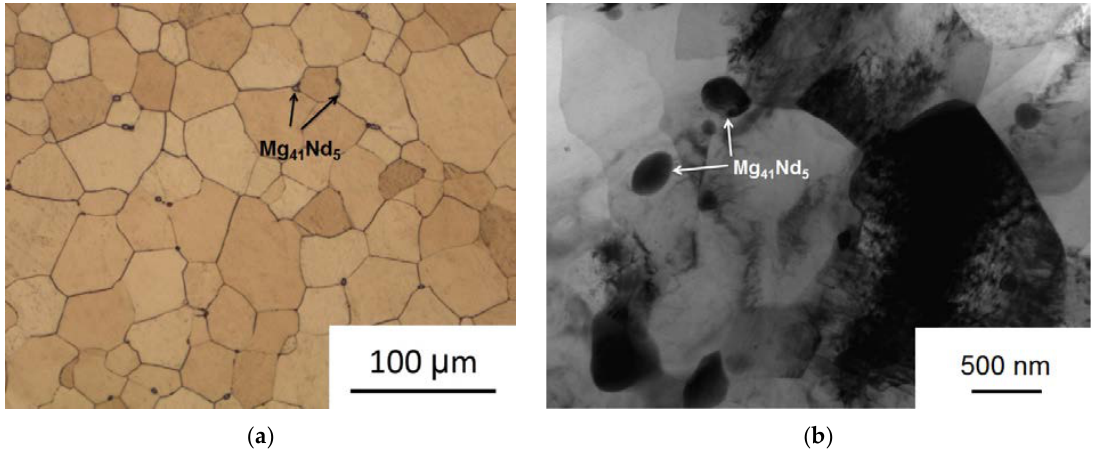
Figure 3. The microstructure of alloy WE43 in the initial (annealed; a ) and deformed ( b ) states.